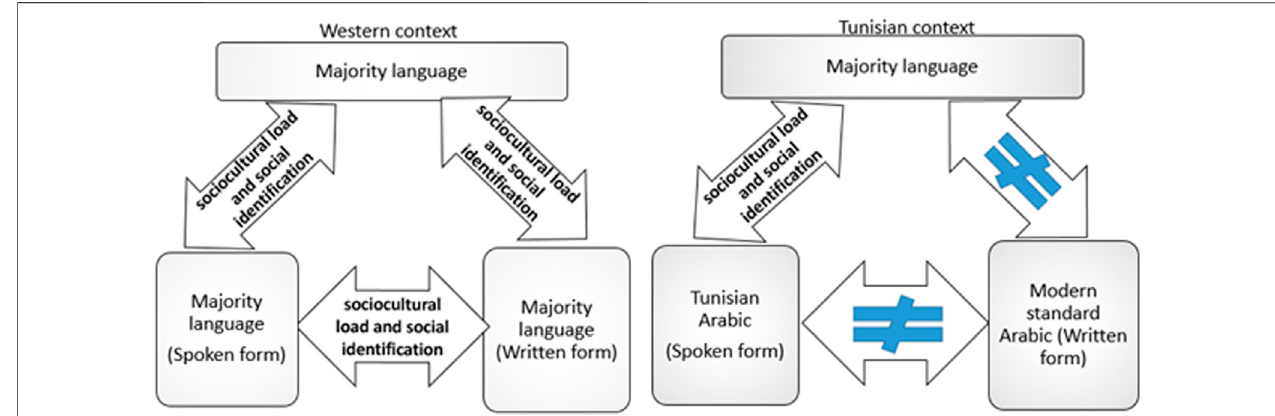
FIGURE 5 | Difference in the socio-cultural and social identi fi cation value of literacy language in the Tunisian and the Western context.